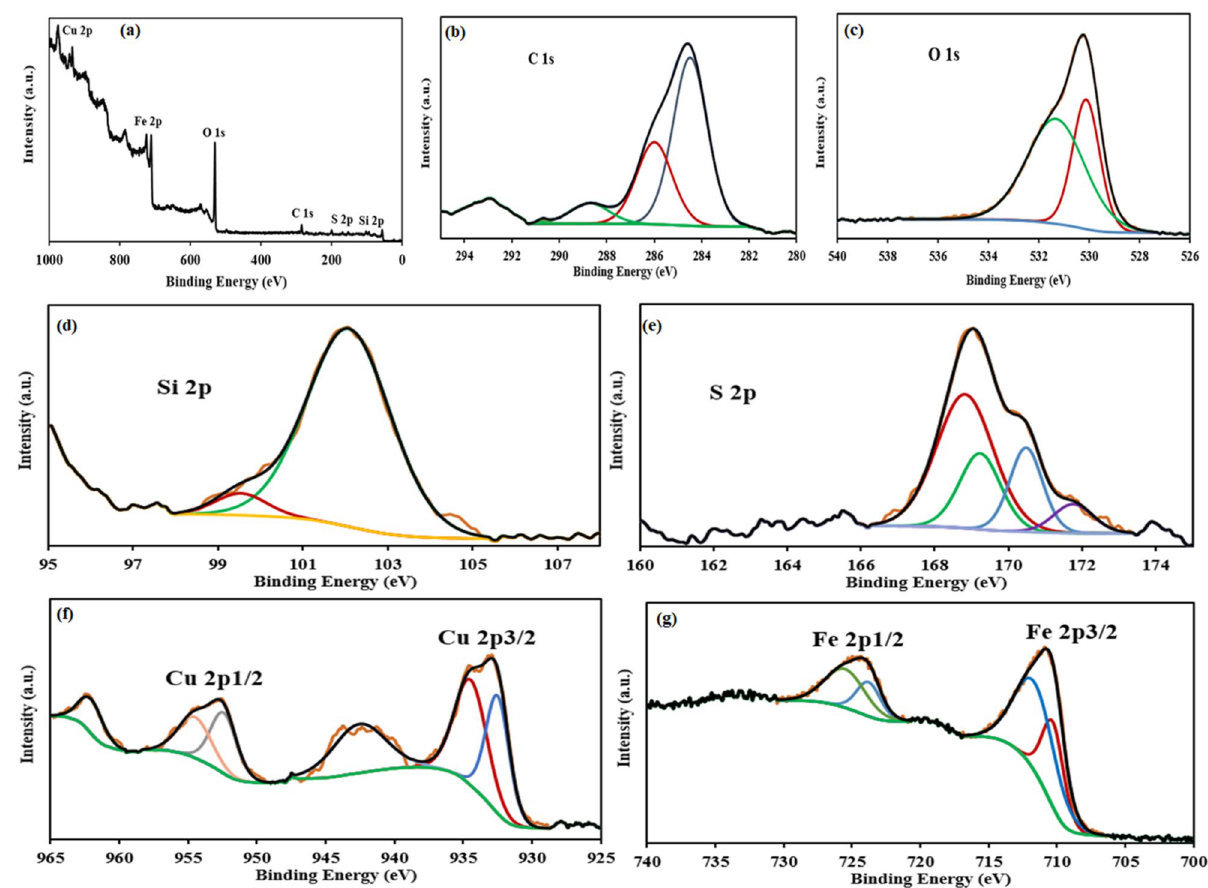
Figure 9. XPS curves of Fe 3 O 4 -PTMS-NAS@Cu